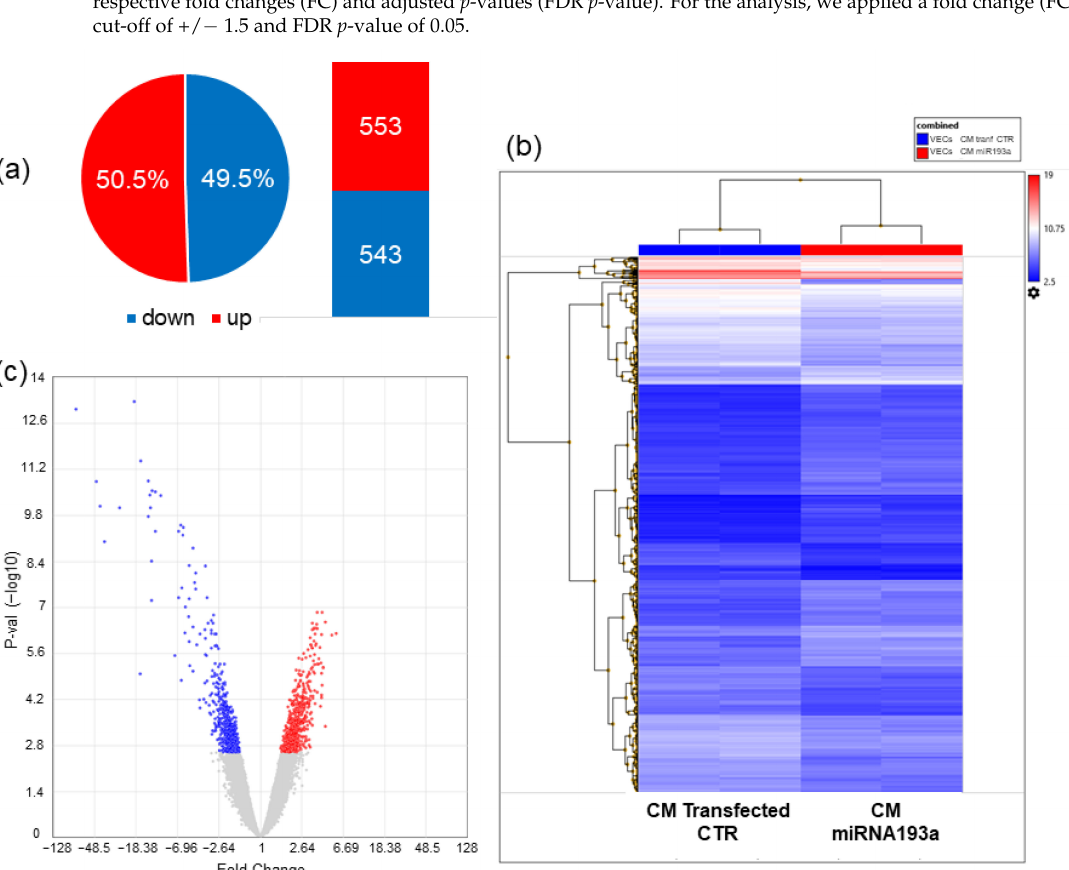
Figure 7. Differentially regulated genes (DRGs) in VECs cultured in CM from MCF-7 cells pre- transfected with miR193a-3p or Transfected CTR (mimic CTR). Figure depicting number of DRGs and pie chart representation of up- and down-regulated genes as percent (%) of total number of DRGs ( a ). Heatmap representation of DRGs between CM miR193a vs CM from transfected CTR ( b ). Volcano plot showing the most up-regulated genes, the most down-regulated genes (green), and the most statistically significant genes are towards the top ( c ). Transcriptome Analysis Console (TAC, Applied Biosystems) was used for analyzing gene expression